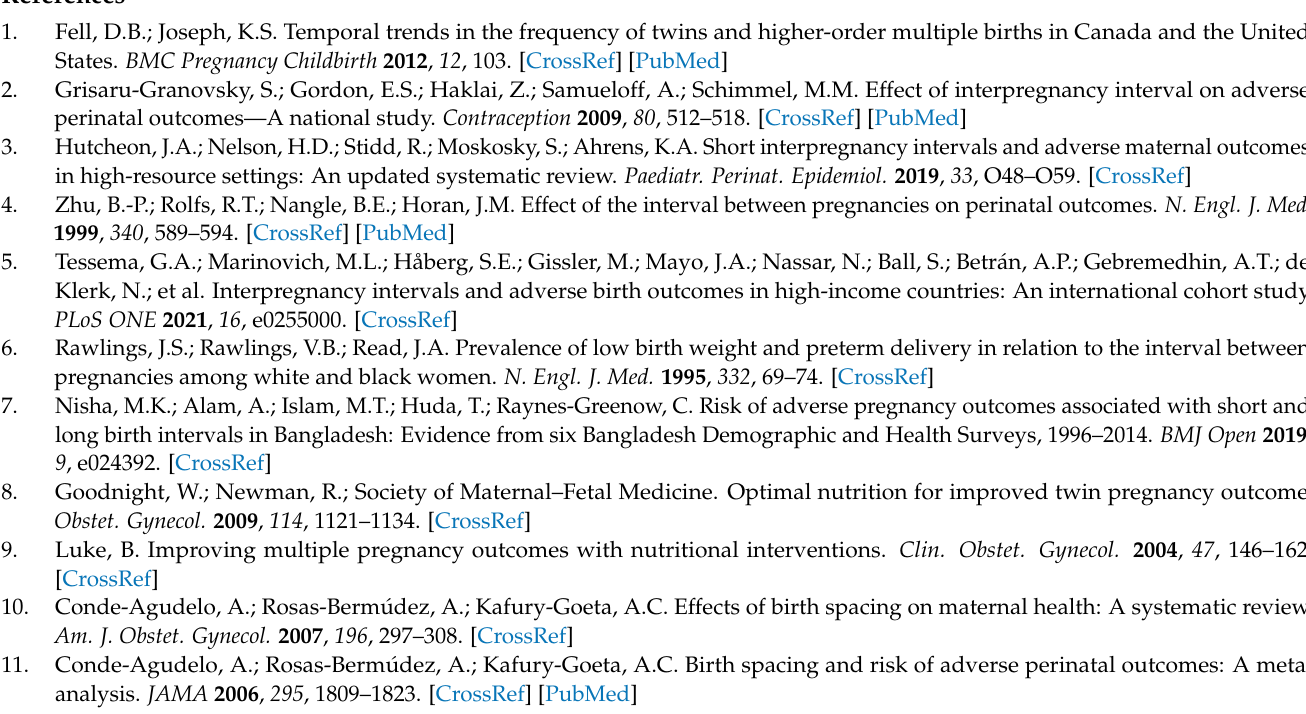
Table S2: Maternal outcomes of the different IPI groups as compared to women with optimal IPI (reference group); Table S3: Neonatal outcomes of the different IPI groups as compared to women with optimal IPI (reference